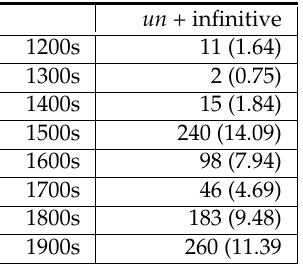
Table 4. un + infinitive in CdE (raw figures and frequency per million